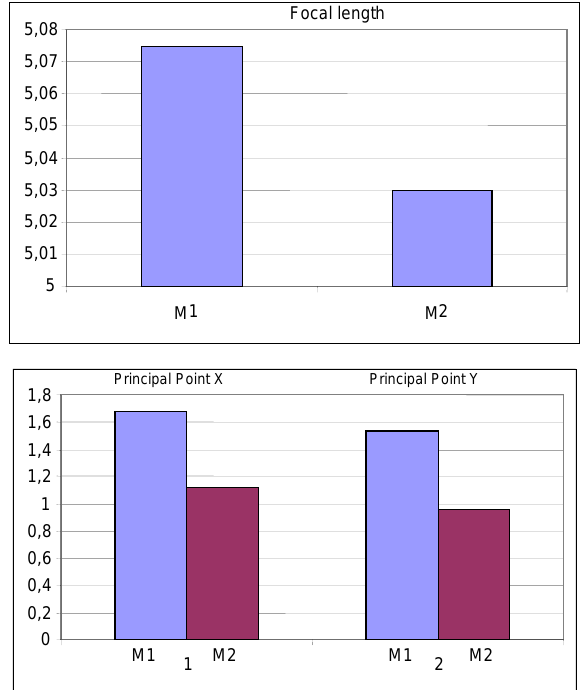
Fig 3. Results of cameras calibration: determined focal length and coordinates of principal point (mm) The camera format size W × H (3,5139 × 2,6791 mm)